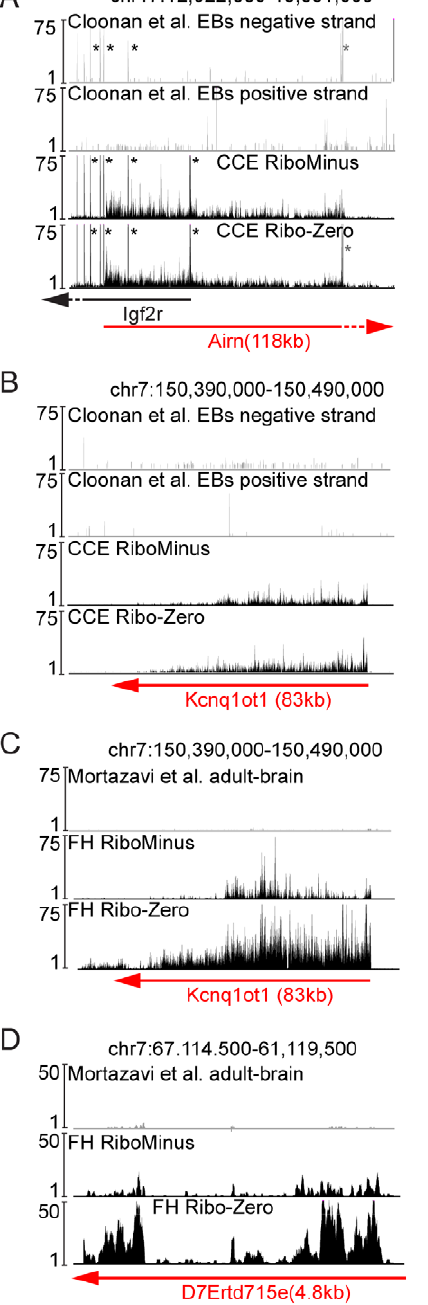
Figure 5. Ribo-depleted RNA-Seq detects macro ncRNAs more efficiently than polyA RNA-Seq. ( A ) UCSC genome browser screen shot as in Figure 4A of the Airn macro ncRNA gene. The Cloonan et al. EB polyA RNA-Seq (grey, top), the RiboMinus CCE and Ribo-Zero CCE RNA-Seq data (black, bottom) are shown. Black asterisks mark the signals from the protein-coding mRNA Igf2r and grey asterisks mark the position of a pseudogene expressed from chr.15 [41]. Note that the ncRNA Airn is 118 kb in length (red arrow, extends outside the region shown) and overlaps exons 2 and 1 protein-coding Igf2r gene (black arrow, extends outside the region shown) in antisense orientation. Therefore Airn and Igf2r signals are visible in the CCE data that has no strand-specific information. For Cloonan et al., strand-specific informa- tion was available and Igf2r signals are visible on the negative strand (black asterisks, top) whereas only a low amount of signals are visible on the positive strand expressing Airn . ( B ) As in A showing the